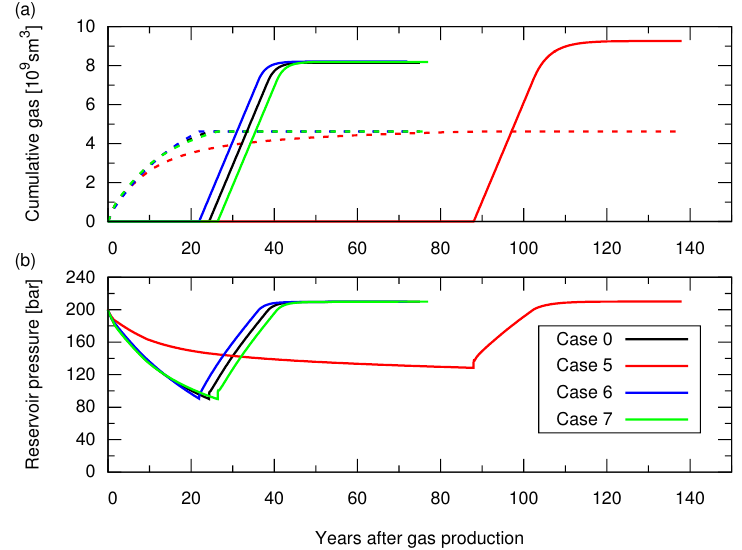
Figure A2. Simulation results of the CO 2 injection following the hydrocarbon gas production for cases 0 and 5 to 7; the influence of the aquifer water encroachment was studied in Section 3.2 of the main text. See Table A1 for the descriptions of these cases. ( a ) Cumulative amount of the produced CH 4 in the dotted lines and cumulative amount of the injected CO 2 in the solid lines; ( b ) Average pressure at the datum depth of 2015 m as a function of time.